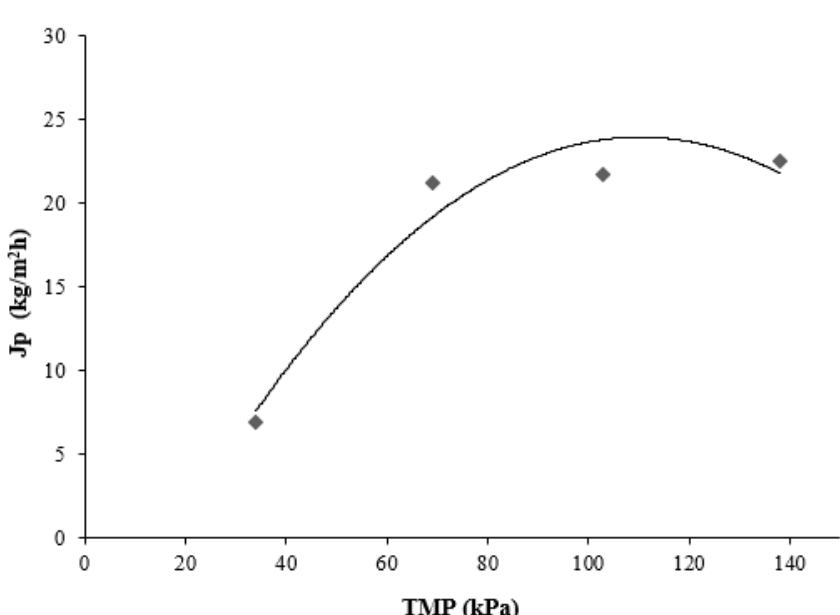
Figure 3. Permeate flux as a function of TMP. Conditions (T = 21 °C, Qf = 77.8 L/h).